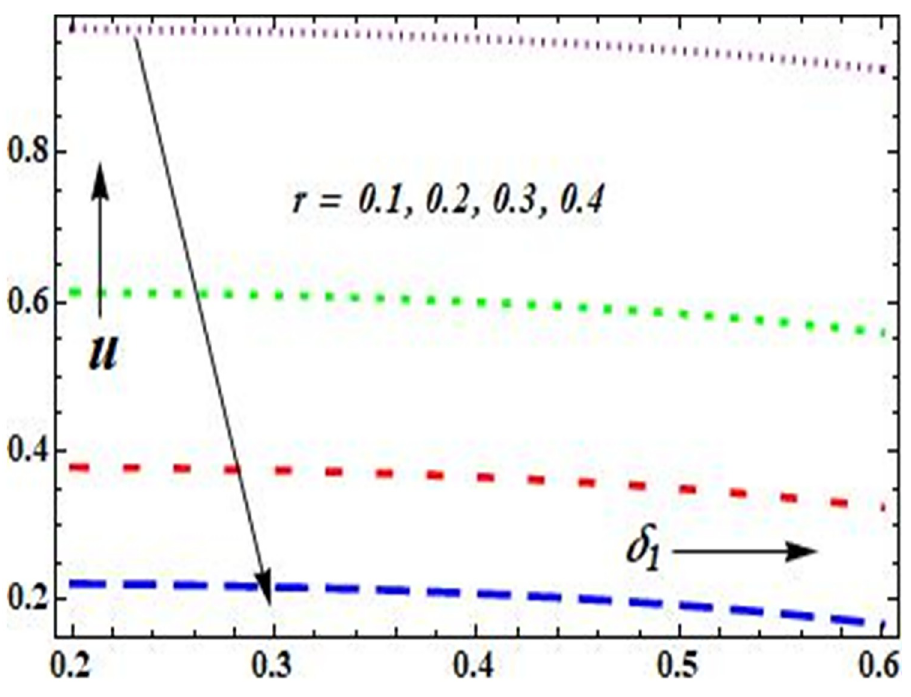
Fig 24. Plot of u on r & δ 1 with ϕ ¼ π